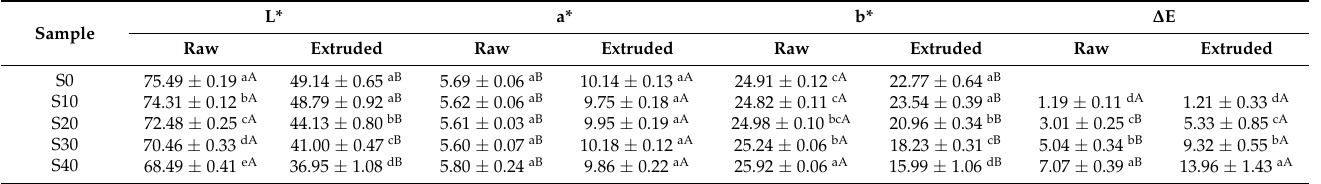
Table 2. Color characteristics of the raw blend and dried